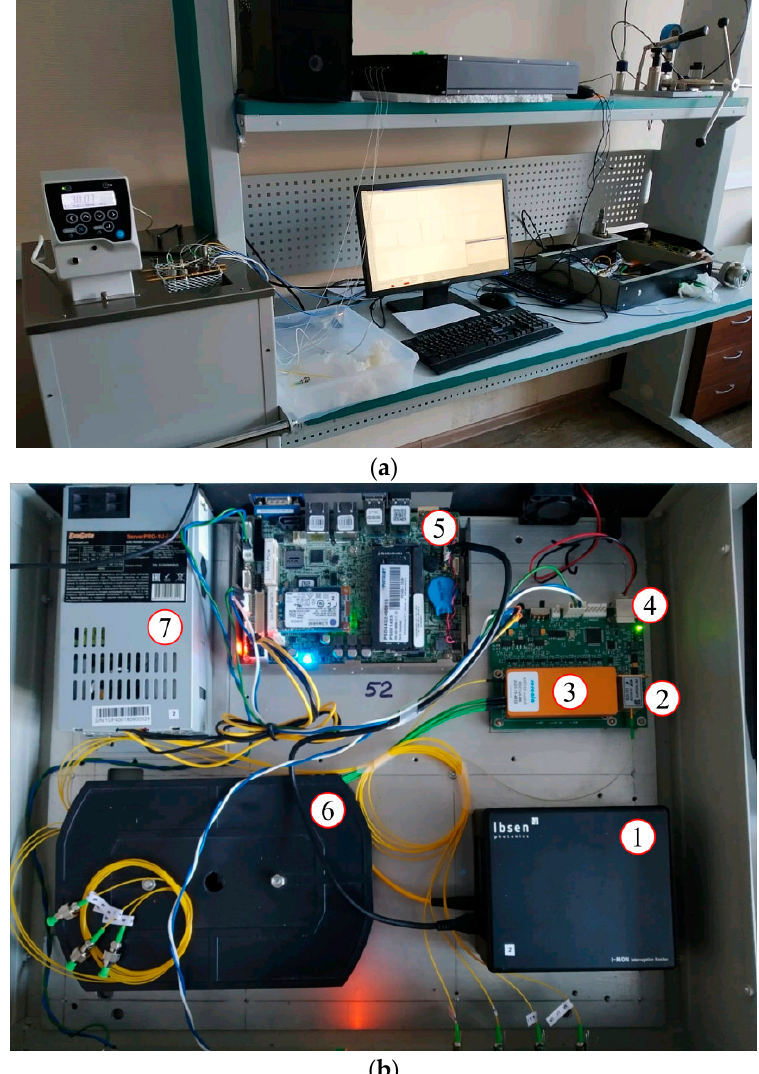
Figure 5. Experimental setup ( a ); FBG interrogator ( b ): 1 – IBSEN I-MON 512 USB; 2 – laser source SLD-761-HP1-DIL; 3 – optic channel switch Sercalo MEMS switch rSC 1 × 8; 4 – laser source and